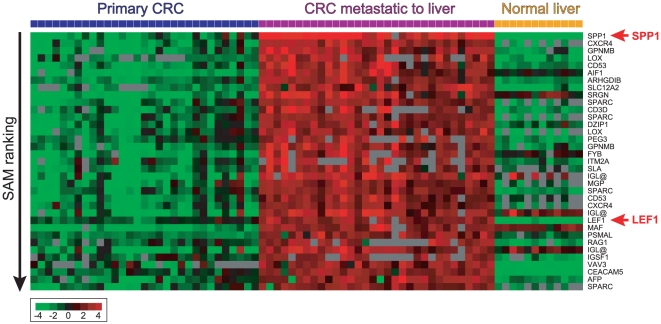
Heatmap showing the top 35 ranking genes, based on SAM analysis, with greatest increased expression in CRC with CLM compared to primary CRC or normal liver.Rows represent individual genes and columns represent individual tissue samples. In each tissue sample, the log2 ratio of abundance of transcripts of each gene relative to its mean abundance across all tissue samples is depicted according to the color score shown at the bottom. Grey indicates missing or excluded data.